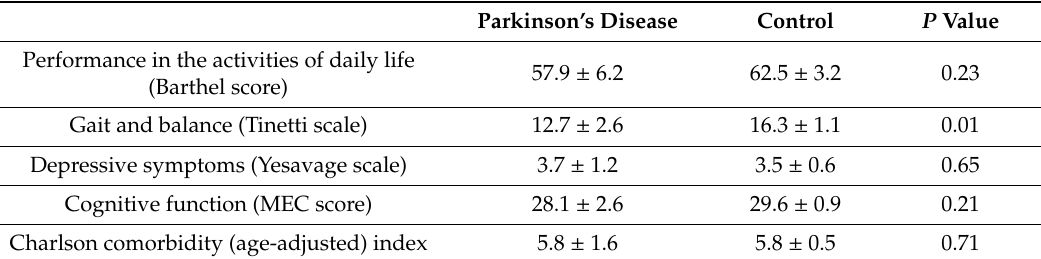
Table 2. Psychogeriatric evaluation of study participants. We reported mean ± standard deviation. For comparisons between groups the U Mann–Whitney test. T was